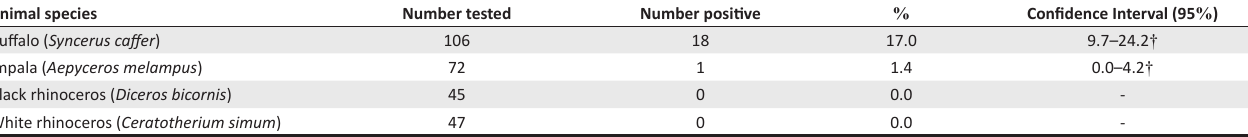
TABLE 1: The distribution of the Brucella seropositive wildlife ungulates from selected game parks in Zimbabwe. Animal species